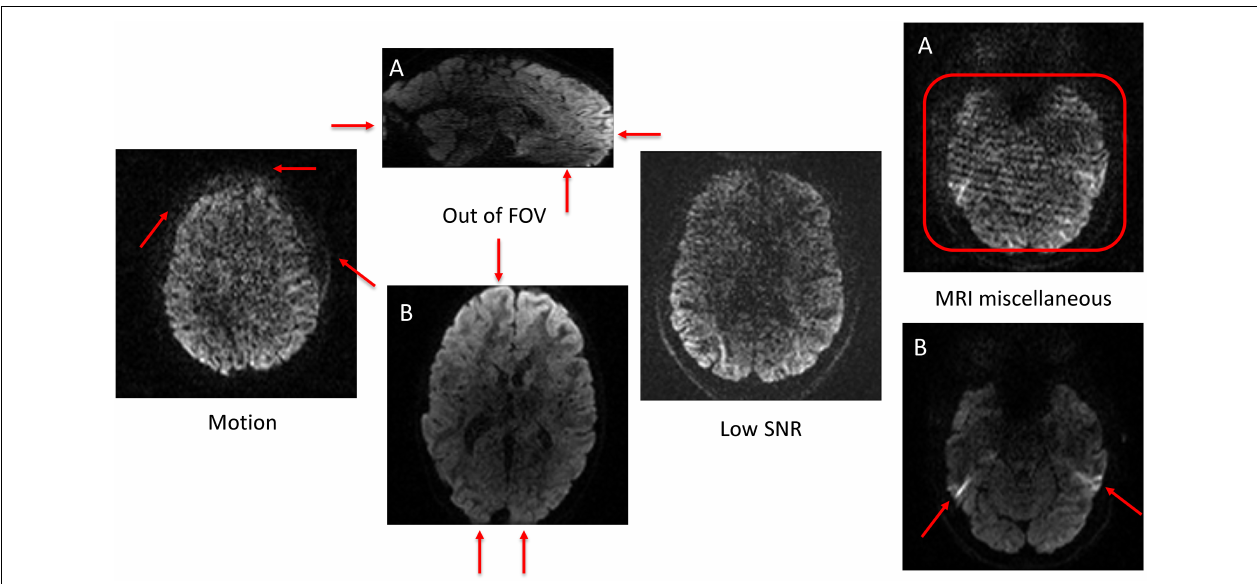
FIGURE 4 | Examples of the four artifact classes. Artifact patterns are demonstrated with red arrows or rectangles. The motion artifact blurring patterns are observable across the border between the brain and the background as depicted by the red arrows. To better observe the out of FOV class, two views of the same volume were depicted [ (A) : Sagittal and (B) : Axial]. The example for the low SNR class, shows a poor signal to noise ratio all over the image. Two different artifact types (form two different volumes) belonging to the MRI miscellaneous artifact class are shown in the right side of the figure [ (A) : Herringbone style artifacts are evident in the region shown by the red rectangle; (B) : Susceptibility artifact are show on both sides of the brain by the red arrows].